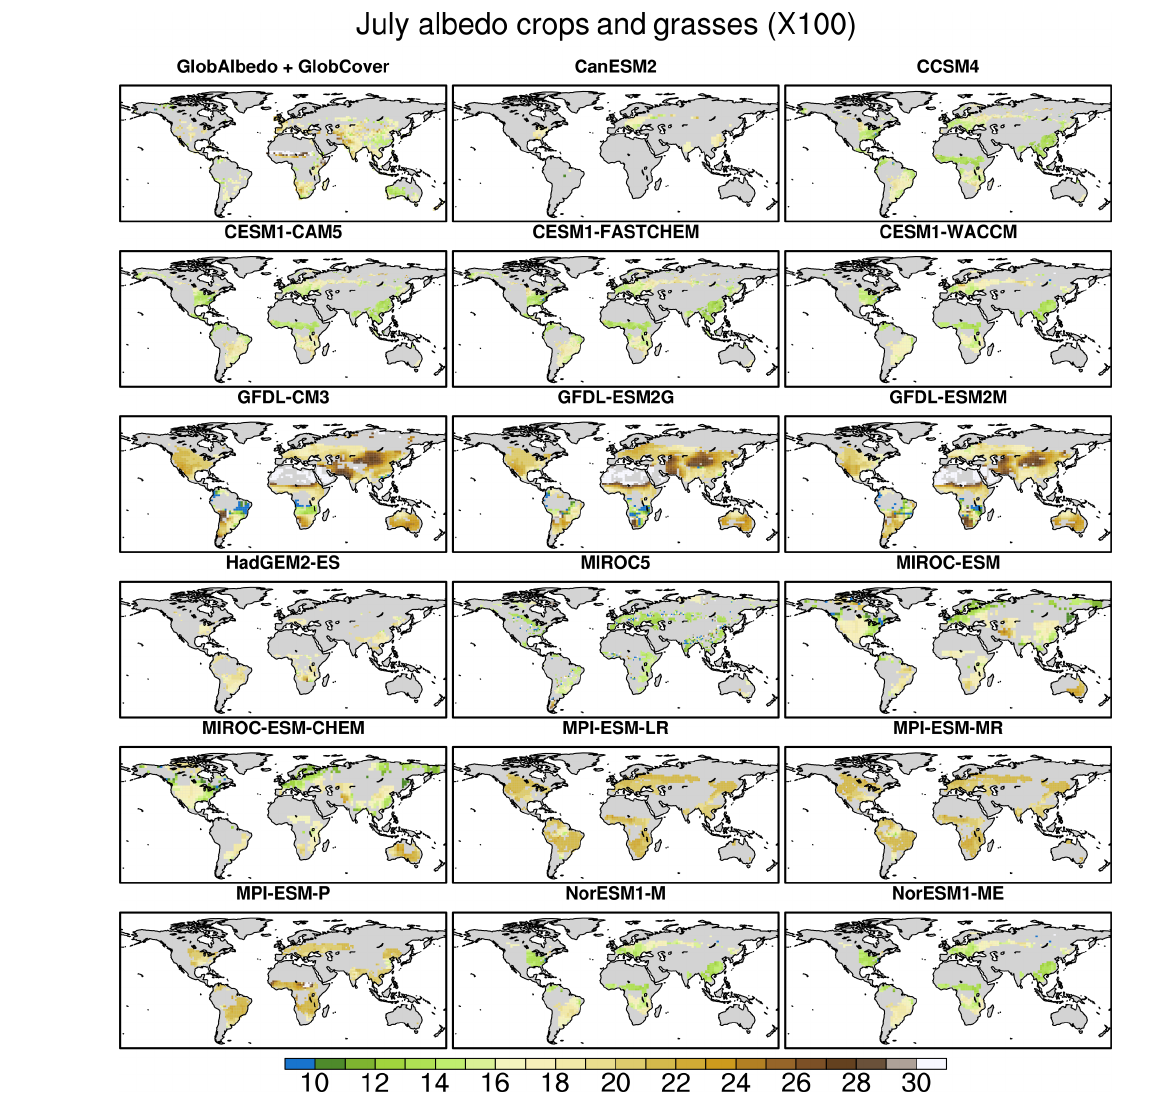
Figure 8. Present-day July albedo of crops–grasses according to the combined observational data from GlobAlbedo (over the 1998–2011 pe- riod) and GlobCover (2005–2006, top left corner), as well as in the analysed CMIP5 models (the climatology over the 2000–2004 period was reconstructed). Note that the albedo values have been multiplied by 100 to facilitate